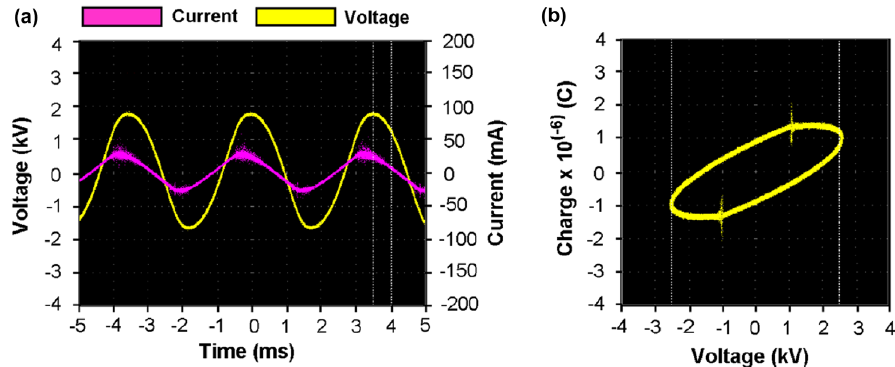
Figure 3. ( a ) Characteristic waveform of voltage and current in the strong ionization dielectric barrier discharge and ( b ) the charge–voltage Lissajous curve as shown on the oscilloscope screen.